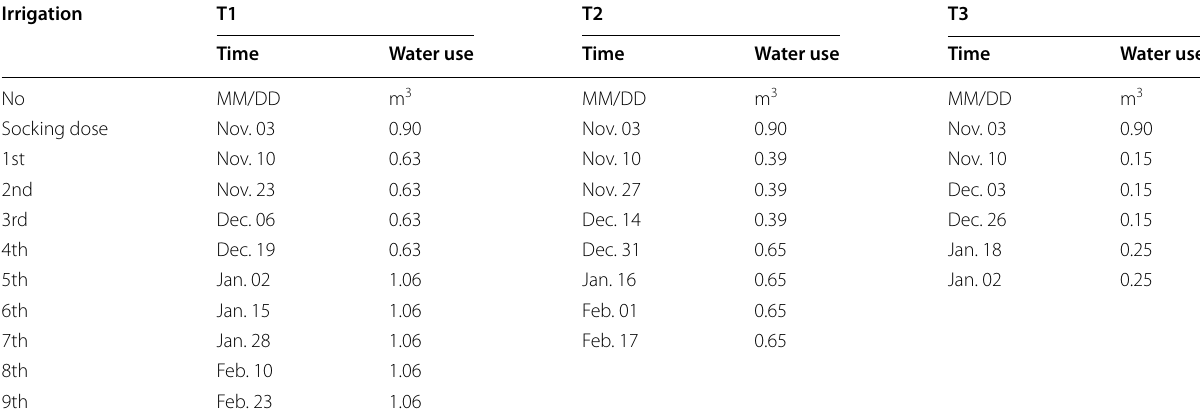
T 1, T 2 and T 3 represent 30, 50 and 70% soil moisture depletion levels, respectively. The values are means